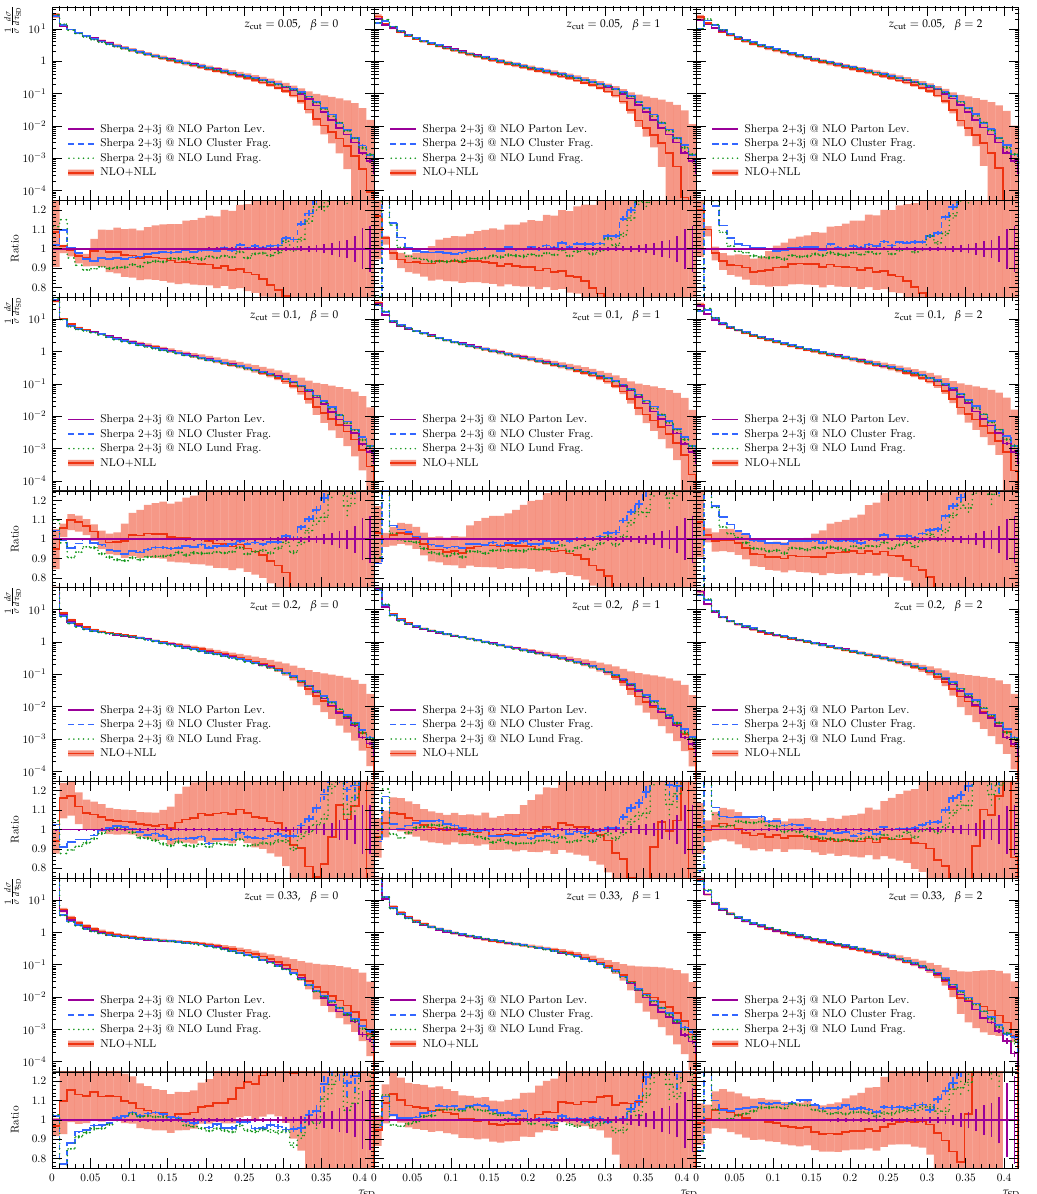
Figure 3. Comparison of NLO+NLL matched predictions for soft-drop thrust to Sherpa MEPS@NLO simulations with up to 3 jets at NLO at parton level and with cluster and string fragmentation